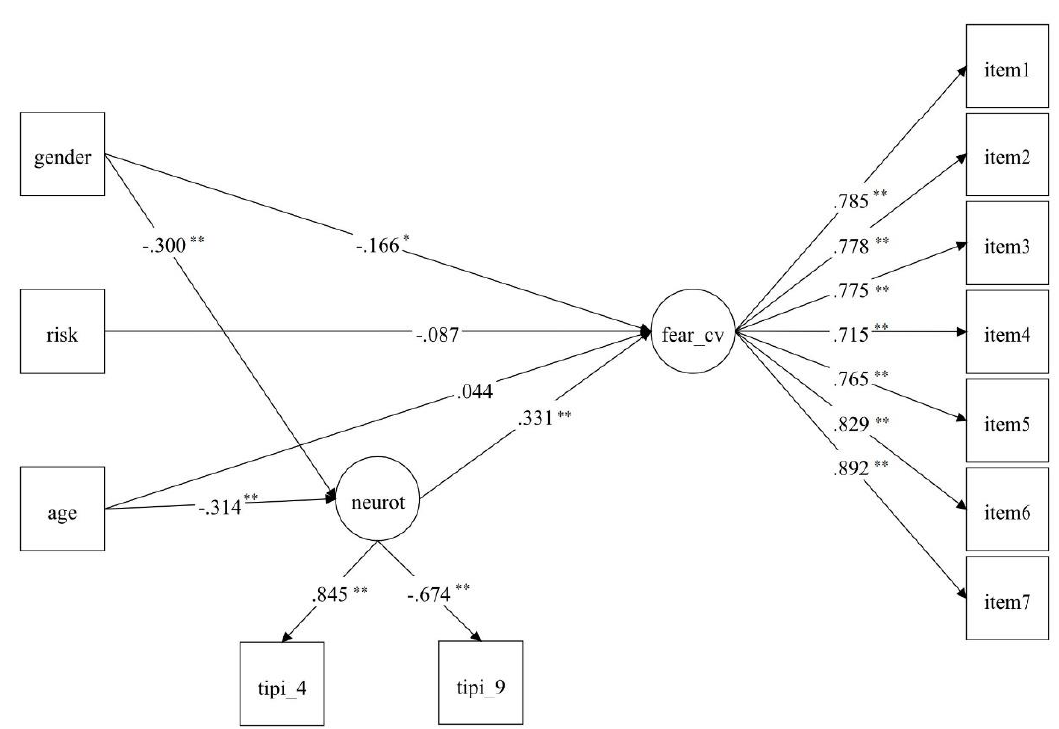
Figure 1. Structural equation model with standardized factor loadings. Reference group for gender: Male. Reference group for risk: Not belong to any risk group. Note: risk = risk group; neurot = Neuroticism; fear_cv = Fear of Covid-19; tipi_4 = anxious, easily upset; tipi_9 = calm, emotionally stable. * p < 0.002; ** p < 0.001.